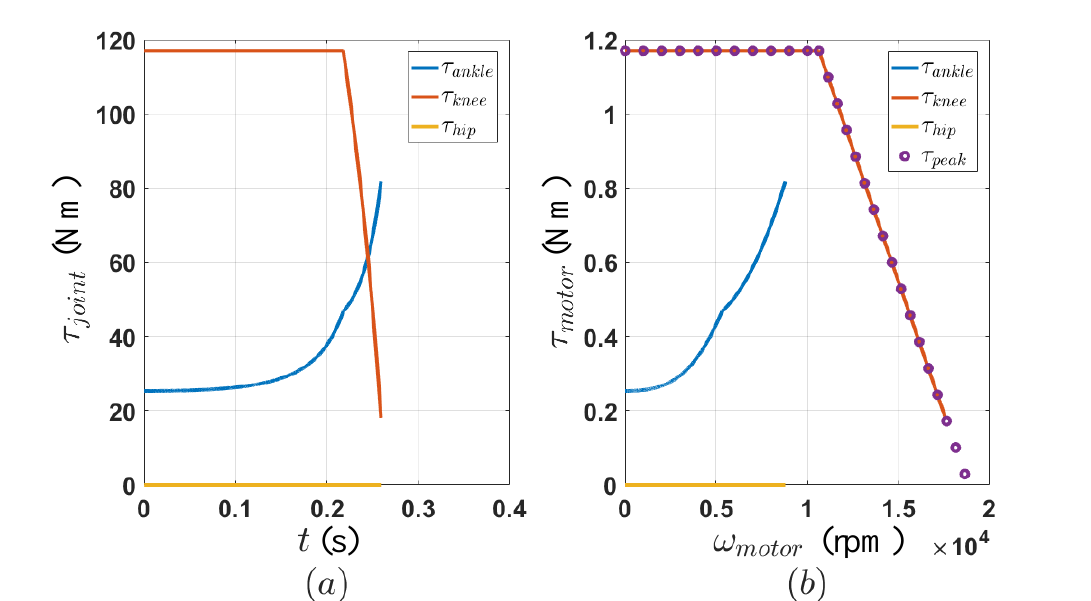
Figure 6. All three joints are equipped with the same K044100-6Y-4.98Ams motor and the same reduction ratio of i r = 100. ( a ) shows the torque of each joint; and ( b ) represents relationships between the motor torque and